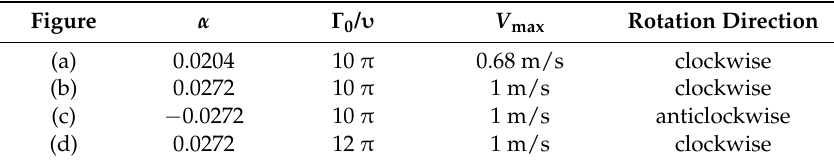
Table 1. The simulation parameters in Figure 2.